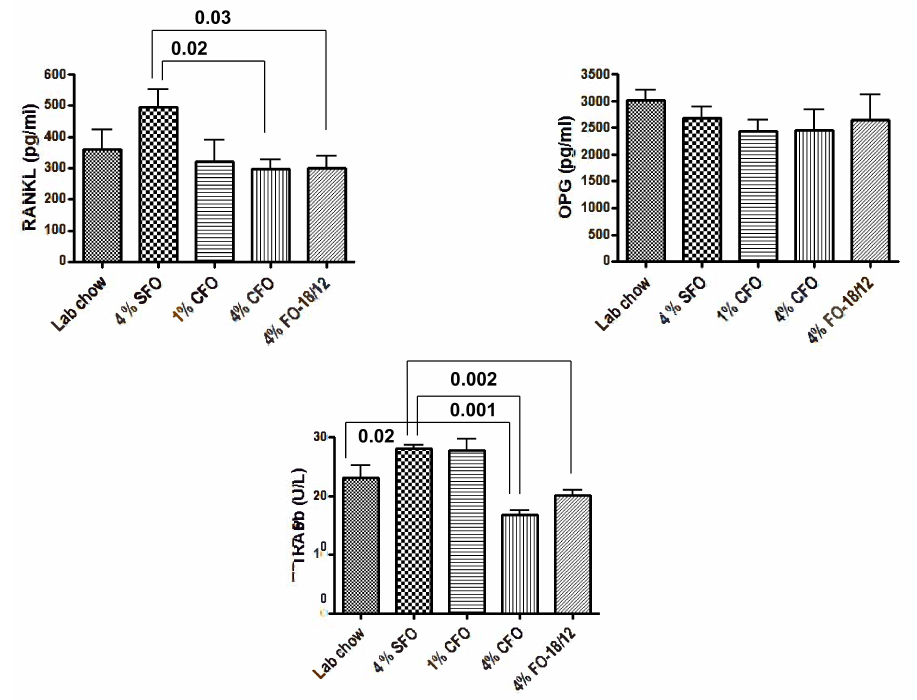
Figure 3. CFO modulates serum bone resorption markers. Twelve-months-old C57BL / 6 mice were fed experimental diets for 12 months. Twenty-four-month-old mice were then sacrificed, and serum was collected and analyzed for bone resorption marker TRAP 5b, osteotropic factors RANKL, and its decoy receptor OPG by standard ELISA techniques. Each value represents the mean ± S.E.M. n = 4–6 mice per group. P -value < 0.05 was considered significant by Student’s t-test. SFO, sa ffl ower oil containing 70%–80% ω -6 linoleic acid; CFO, concentrated fish oil containing 46.5% EPA and 37.5% DHA; FO-18 / 12, regular fish oil containing 18% EPA and 12%